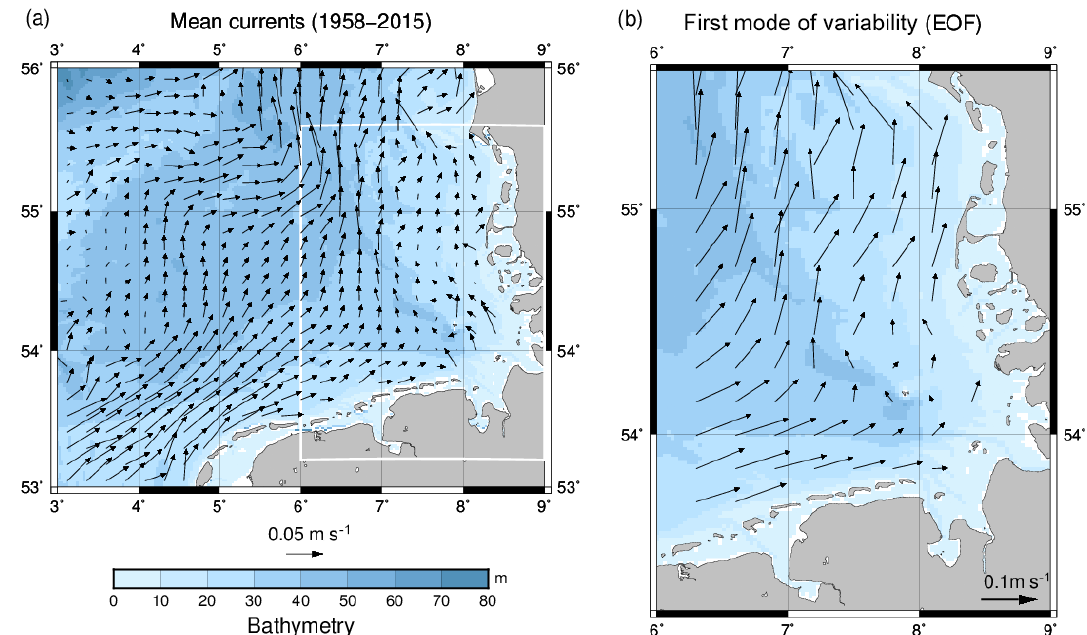
Figure 2. (a) Mean currents in the inner German Bight, calculated running a 2-D version of model TRIM for the period January 2014– August 2015. (b) Leading mode of variability (first empirical orthogonal function (EOF); see von Storch and Zwiers, 1999) of daily 25h mean currents obtained from a PCA restricted to data from the white box region in panel (a) (Callies et al., 2017). Vector densities in the two plots do not represent spatial resolution of the underlying model (1.6km). Vectors in the right panel are scaled in such a way that the EOF represents an anomaly that would arise from the first principal component (PC 1 ) assuming the (positive) value of 1 standard